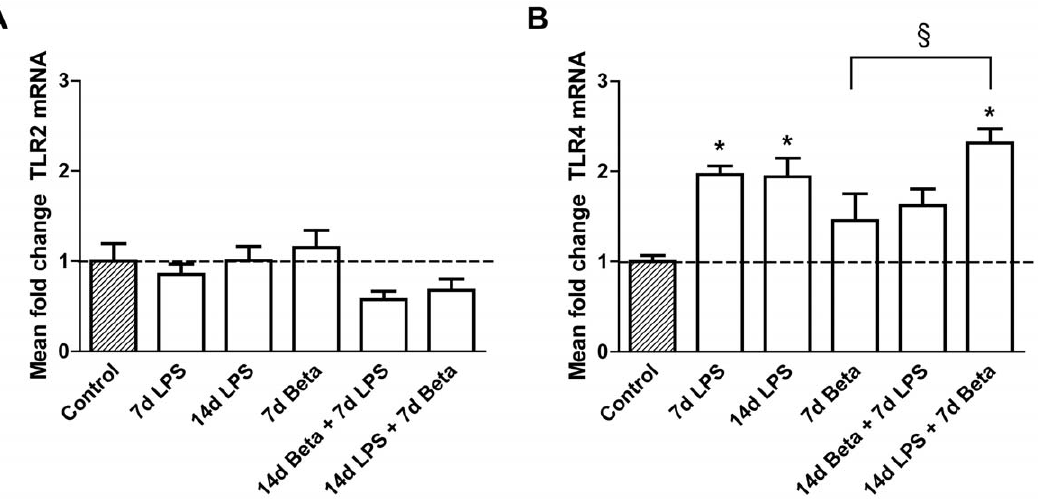
Figure 4. Expression of Toll-Like Receptors (TLR) 2 and 4. TLR2 ( A ) was not differently expressed in experimental groups compared to controls. TLR4 ( B ) mRNA increased in the 7 d LPS, 14 d LPS and the 14 d LPS + 7 d Beta group. * p , 0.05 versus controls and 1 p , 0.05 between experimental groups.